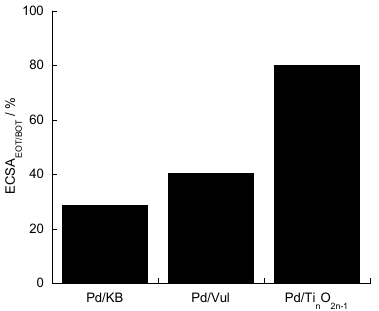
Figure 7. ECSA percentage for the different Pd/support catalysts obtained by the ratio between ECSA at EOT and BOT. Scan rate 5 mV·s − 1 ; 1000 rpm; room temperature and 50 μ g·cm − 2 of Pd loading.